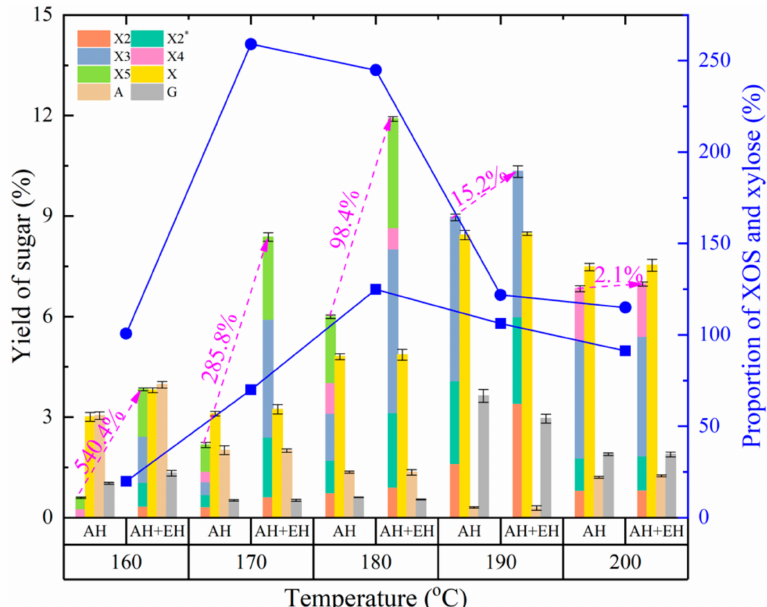
Figure 1. Effects of autohydrolysis pretreatments on sugar yield and the proportion of xylooligosac- charides (XOS) and xylose at different temperatures. AH, autohydrolysis only treatment, no enzy- matic hydrolysis treatment; AH + EH, autohydrolysis plus enzymatic hydrolysis treatment. Squares and solid line, the proportion of XOS and xylose for the autohydrolysis-only treatment; circles and solid line, the proportion of XOS and xylose for the autohydrolysis plus enzymatic hydrolysis treat- ment. The magenta text indicates the percentage increase in the yield of XOS after autohydrolysis plus enzymatic hydrolysis treatment compared with that of the autohydrolysis-only treatment at different temperatures. X2, xylobiose; X2*, an oligosaccharide with a degree of polymerization between X2 and X3; X3, xylotriose; X4, xylotetraose; X5, xylopentaose; X, xylose; A, arabinose; G,